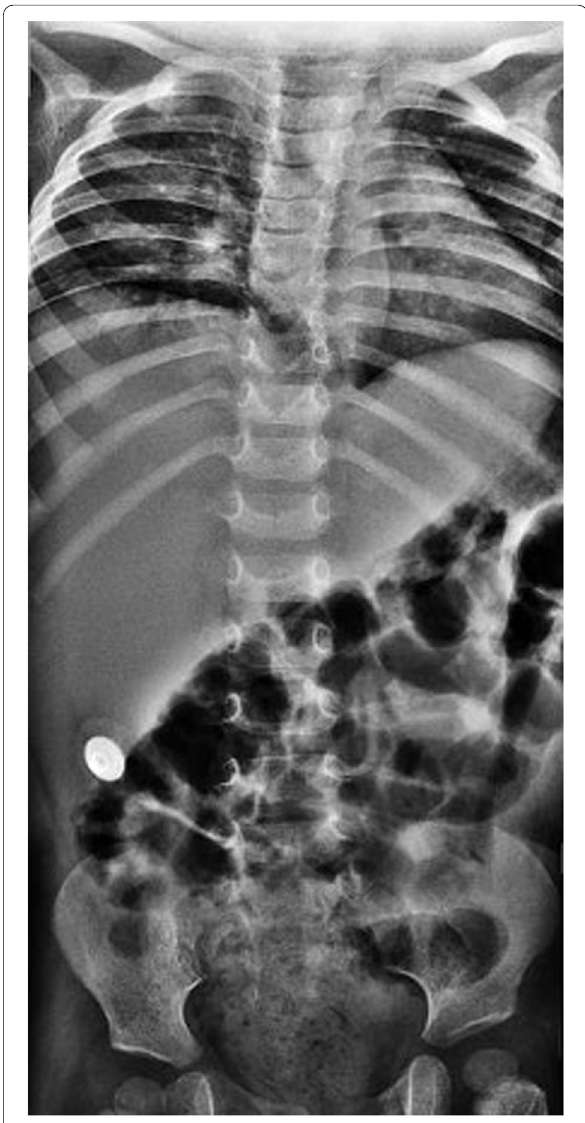
Fig. 1 Ap view of a complete spine radiograph with paravertebral swelling and destruction of